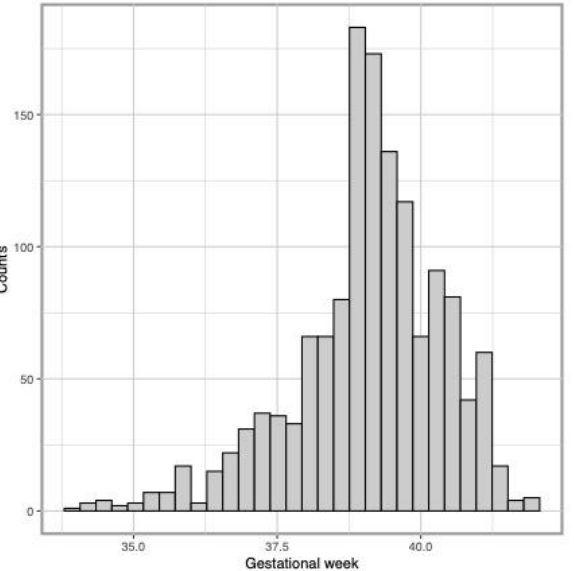
Figure 1. Distribution of gestational age at delivery in CANDLE participants. Phthalate metabolites included in the analysis were detected in 71.3–100% of samples (Table 2). Table 2. Distributions of specific gravity adjusted urinary phthalate concentrations in